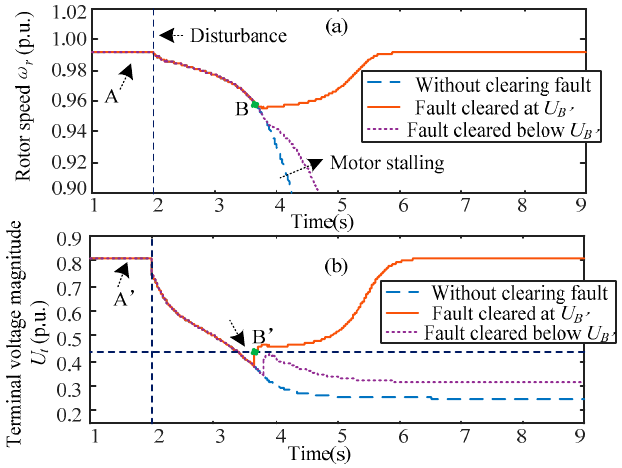
Figure 12. Time-domain simulation of IM stalling after a disturbance: ( a ) rotor speed; and ( b ) terminal voltage magnitude.